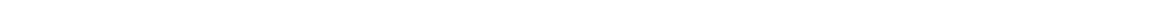
Fig. 1 High-resolution TAD boundaries in fl ies. a Example region of 350 kb showing Hi-C TADs from Kc167 cells. Top panel: Hi-C contact matrix obtained from refs. 15,16 . The size of the bins is variable (mean 570 bp) and depends on the genomic location of the DpnII restriction sites. The chromatin state track contains the fi ve classi fi cations from ref. 29 : Active chromatin, red and yellow; inactive chromatin, black; PcG, blue; HP1, green. The TAD separation score track (Methods section) depicts a normalized measure of the contacts between two fl anking regions (10 – 40 kb, depicted by gray line, blue line depict mean score). The boundaries, estimated using the TAD separation score are shown as vertical lines. The following tracks show normalized ChIP-seq coverage for the known boundary proteins CP190, Beaf-32, and Su(Hw) on Kc167 39 and CTCF 15 . The following tracks contain ChIP – chip data for histone modi fi cations from modEncode 28 . The image was generated using HiCExplorer. This particular region was selected because many different TADs could be seen; other regions can be browsed at http://chorogenome.ie-freiburg.mpg.de. b Histogram of the distance of a boundary to the nearest CP190 (common insulator protein co-factor) peak. c Correlation of histone marks within and between TADs. Each pixel in the matrix represent the Pearson correlation of the histone mark in all TADs at different distances (Methods section). d TAD classi fi cation based on histone marks. The numbers below each TAD type represent respectively: mean length, percentage of genome occupied by the TAD and number of TADs of that type. e Boxplot of consecutive TAD of each type. f TAD-separation score between: active and inactive or PcG, active – active, inactive – inactive, and PcG – PcG. The differences between the groups are all signi fi cant ( p -value < = 7.8E − 5, Wilcoxon rank-sum test). g Classi fi cation of TAD boundaries. TAD boundaries are classi fi ed at promoter if they are within 1000 bp of the annotated TSS. h Histone marks at non-promoter and promoter boundaries. Further marks can be seen in Supplementary Figure 1i. i TAD- separation score for non-promoter and promoter boundaries. j DNase accessibility at non-promoters and promoter